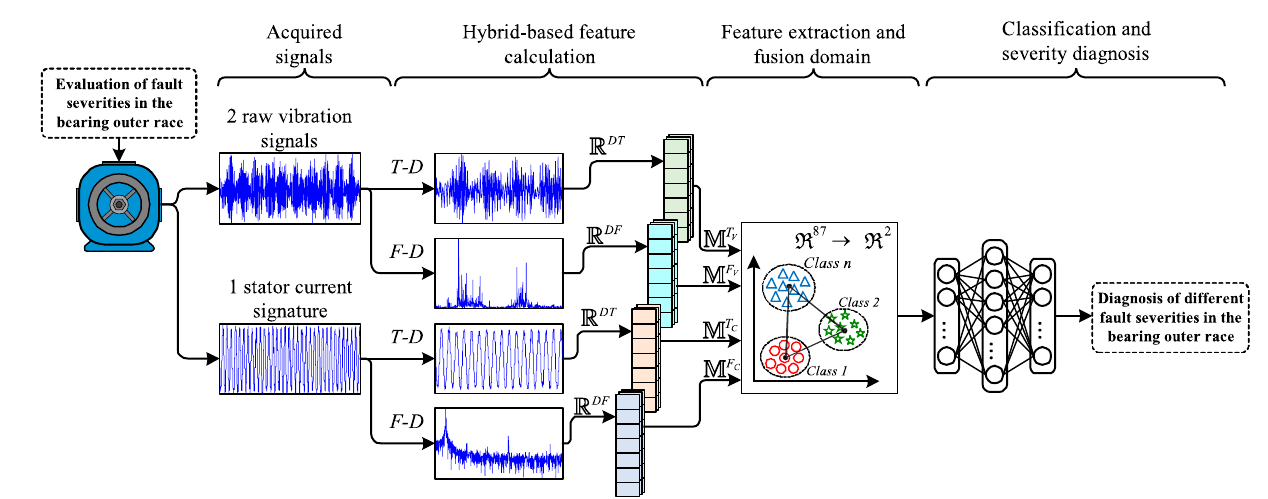
Figure 2. A flow chart of the proposed condition monitoring method for the diagnosis and detection of multiple fault severities that may occurred in the outer race of bearings in IM’s.